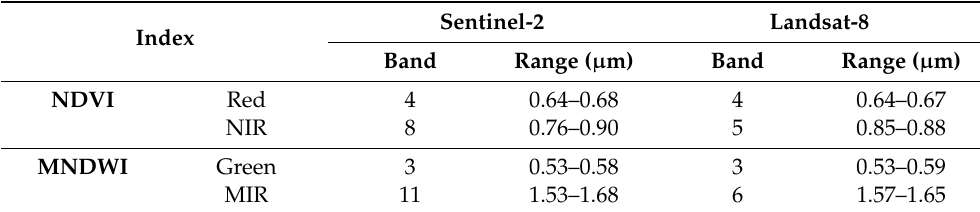
Table 2. Spectral information used for indices